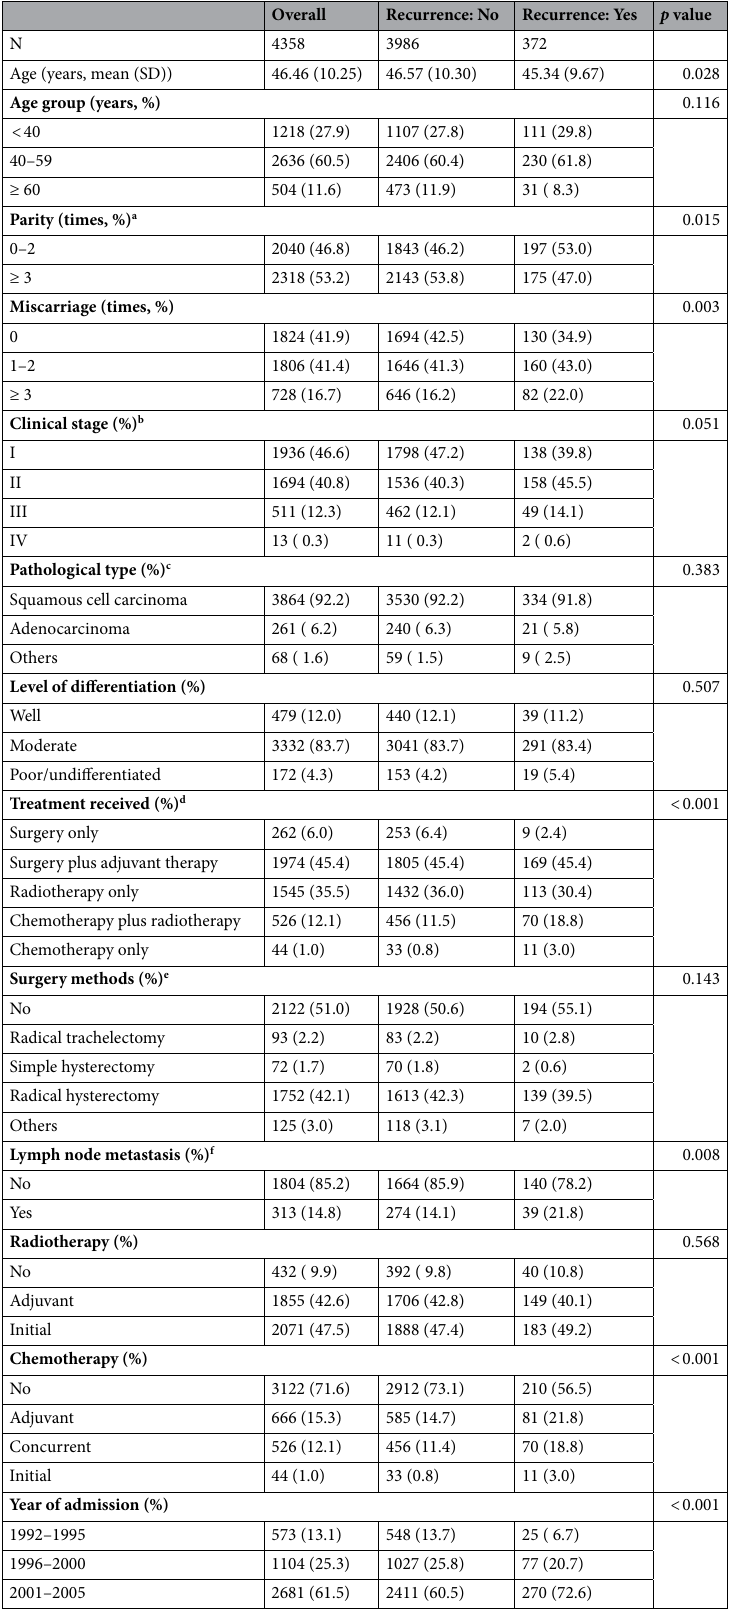
Table 1. Patient characteristics. a 28 missings; b 204 missings; c 165 missings. d 7 missings; e 194 missings; f based on biopsy after